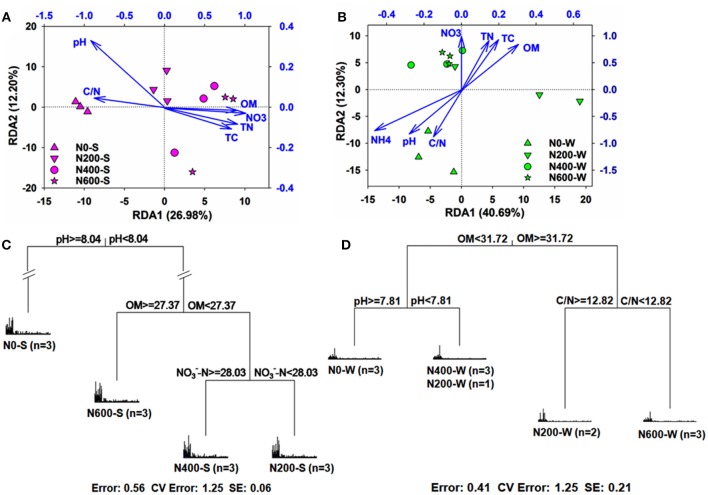
(A,B) Redundancy analysis (RDA) plots depict the correlation between bacterial communities and soil properties in the SM (A, P = 0.001) and WW (B, P = 0.039) seasons; (C,D) Multivariate regression tree (MRT) analysis of bacterial communities under different N treatments in the SM (C) and WW (D) seasons. Specific treatment and the number of samples included in the analysis are shown under bar plots. OM, soil organic matter; NO3/NO3--N, nitrate concentration; NH4, ammonium; TC, total carbon; TN, total N; C/N: C/N ratio. Different shapes of symbols represent different treatments.